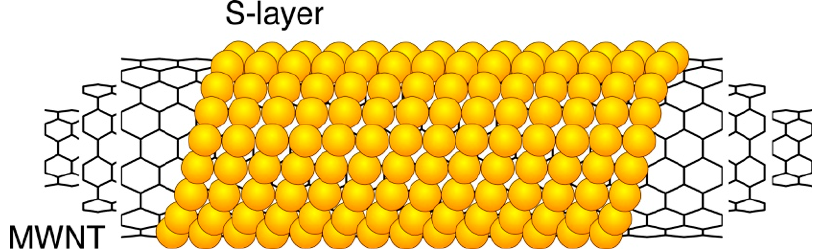
Figure 2. Schematic drawing of an S-layer coated multi walled carbon nanotube.